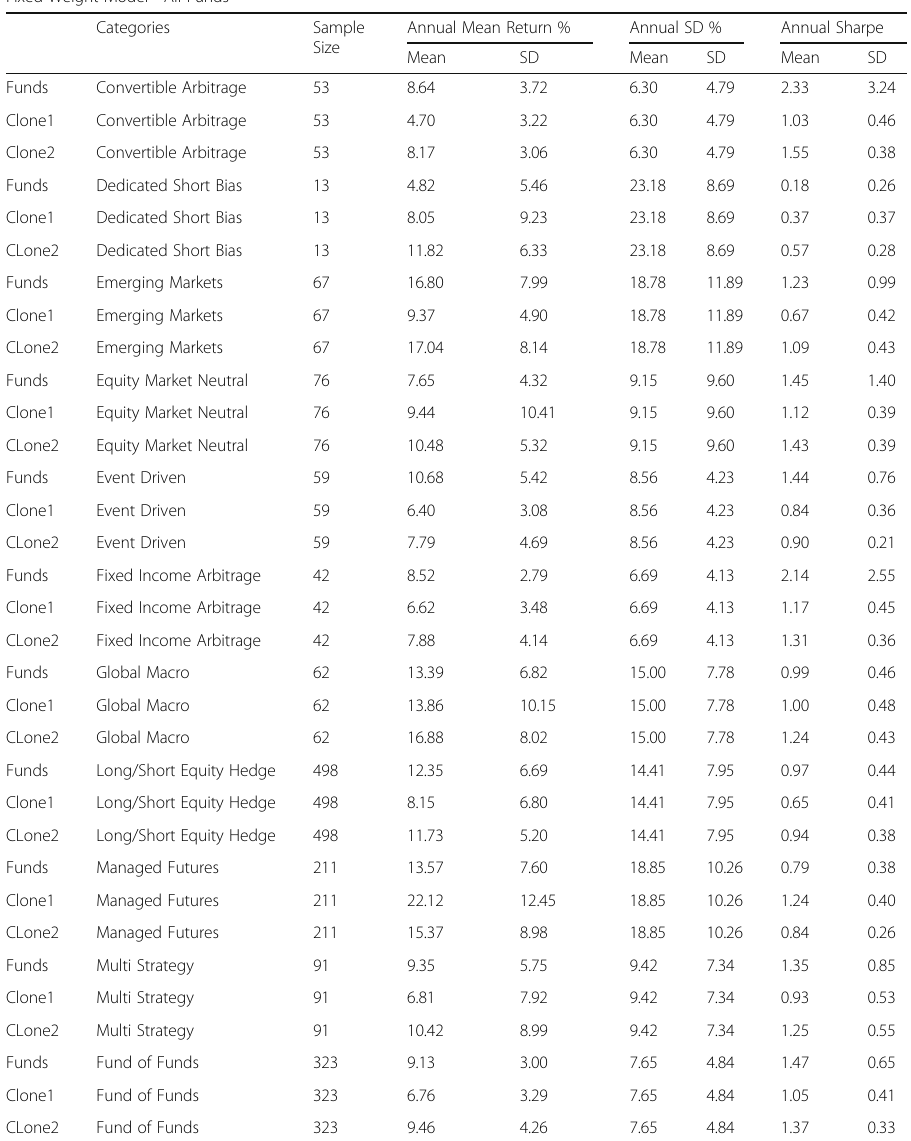
Table 1 Performance comparison for fixed weight model for all funds and their